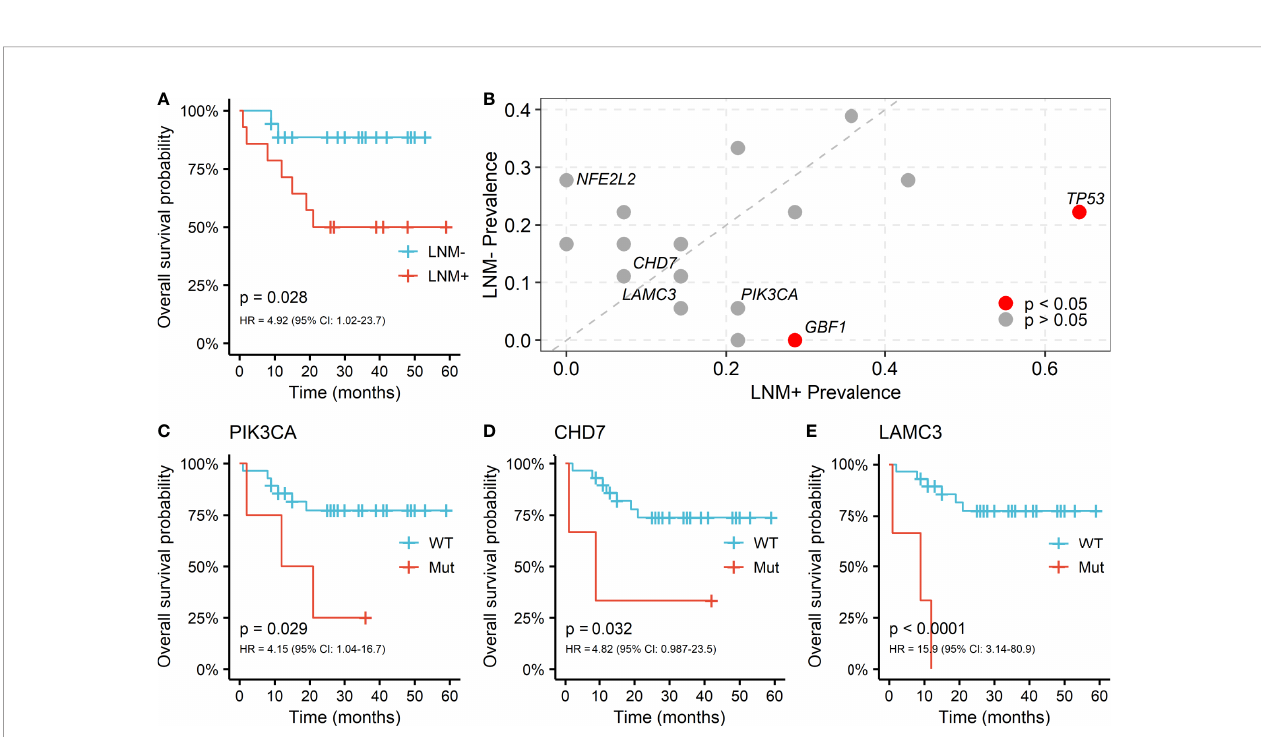
FIGURE 3 | Somatic alterations between different lymph node metastasis (LNM) subgroups and its correlation with OS in PSCC. (A) Kaplan-Meier curve of overall survival by lymph node metastasis (LNM). (B) Enrichment of somatic alterations by lymph node status. Kaplan-Meier curves of overall survival by the mutation status of gene (C) PIK3CA, (D) CHD7 and (E) LAMC3 in PSCC patients. P values of the log-rank test and hazard ratios are shown at the bottom left for each